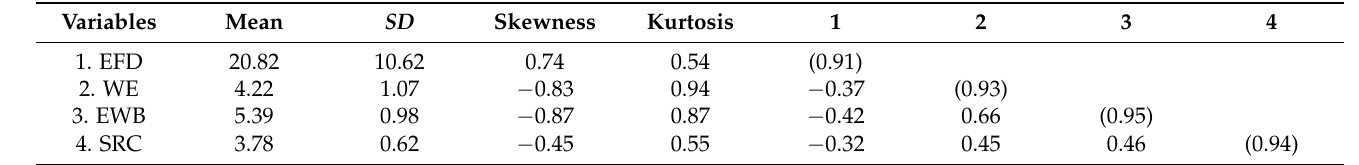
Table 1. Descriptive Statistics and Intercorrelations for Study Variables ( n = 314, imputed).